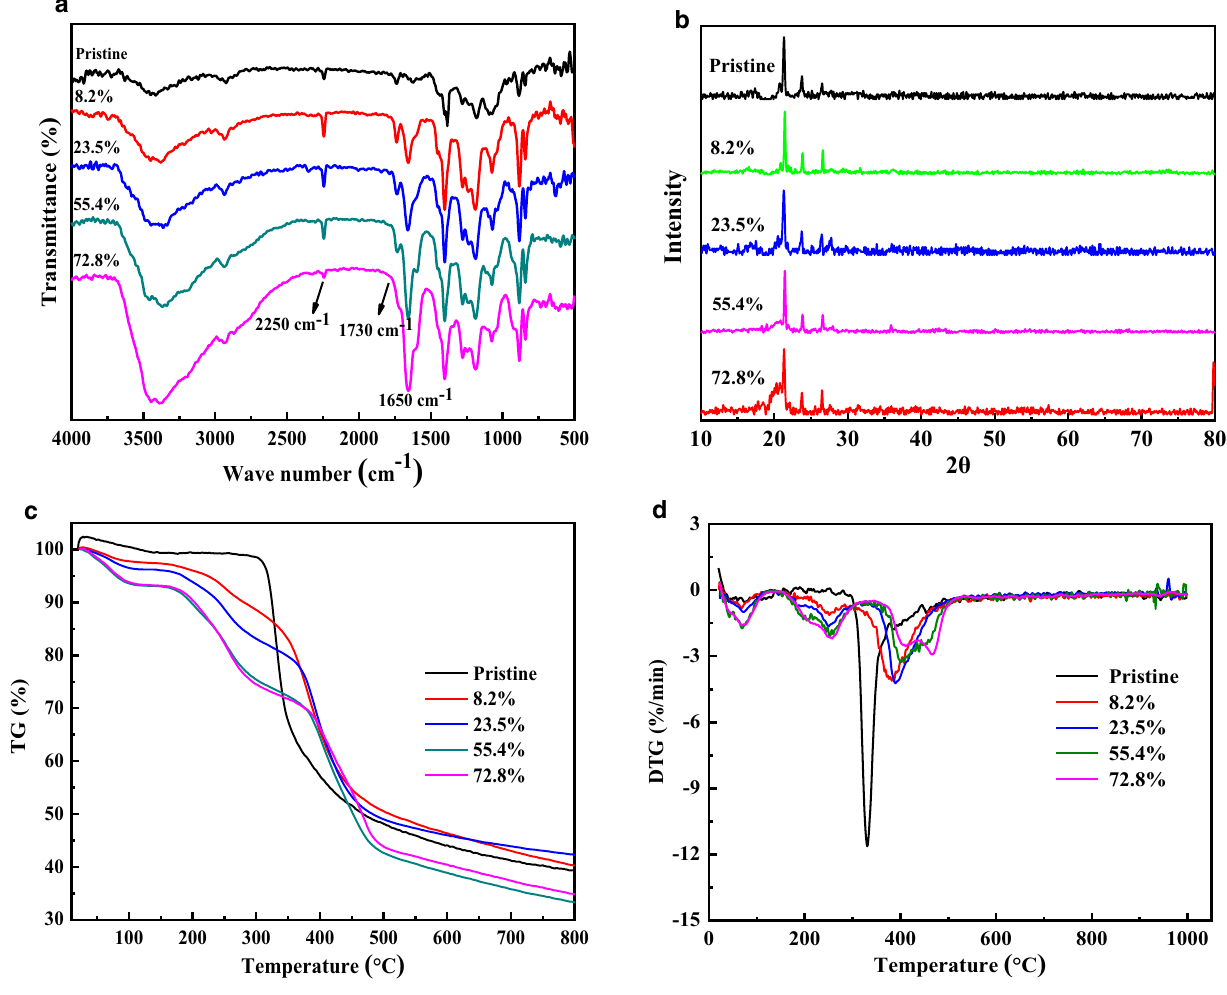
Fig. 6 a FTIR spectra, b XRD patterns, c TGA curves and d DTG curves of AOPAN/PVDF nanofibrous membranes with different nitrile group conversion